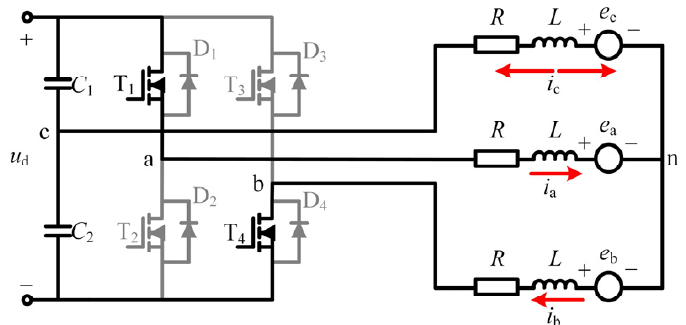
Figure 5. Equivalent circuit diagram under the conduction of power transistors T 1 and T 4 .